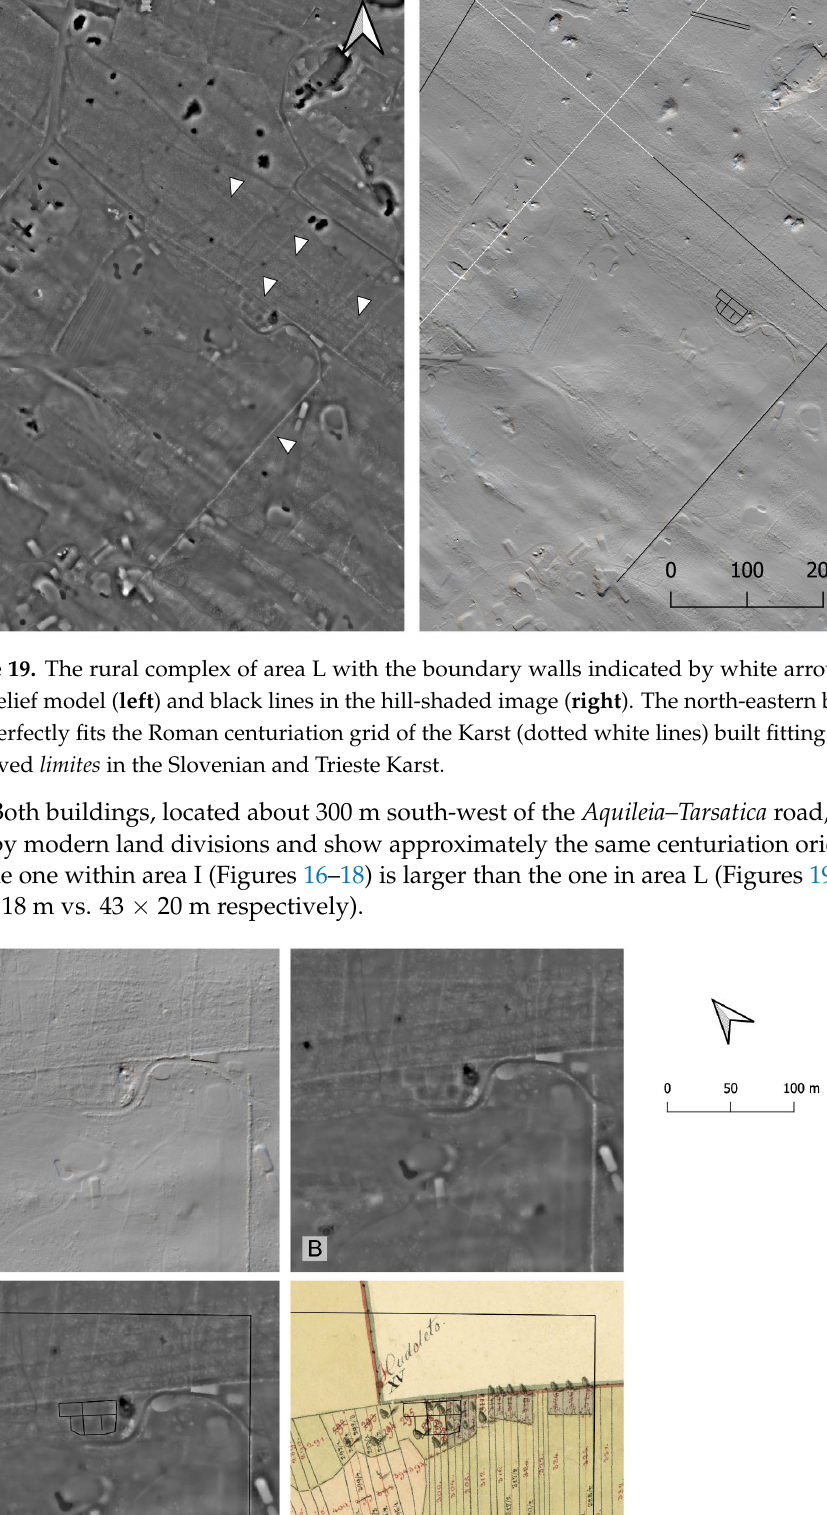
Figure 20. Zoomed view of the rural complex of area L: hill-shaded image ( A ), local relief model ( B ), interpreted local relief model ( C ) and digitized features superimposed onto a 19th century ca- dastral map ( D ).